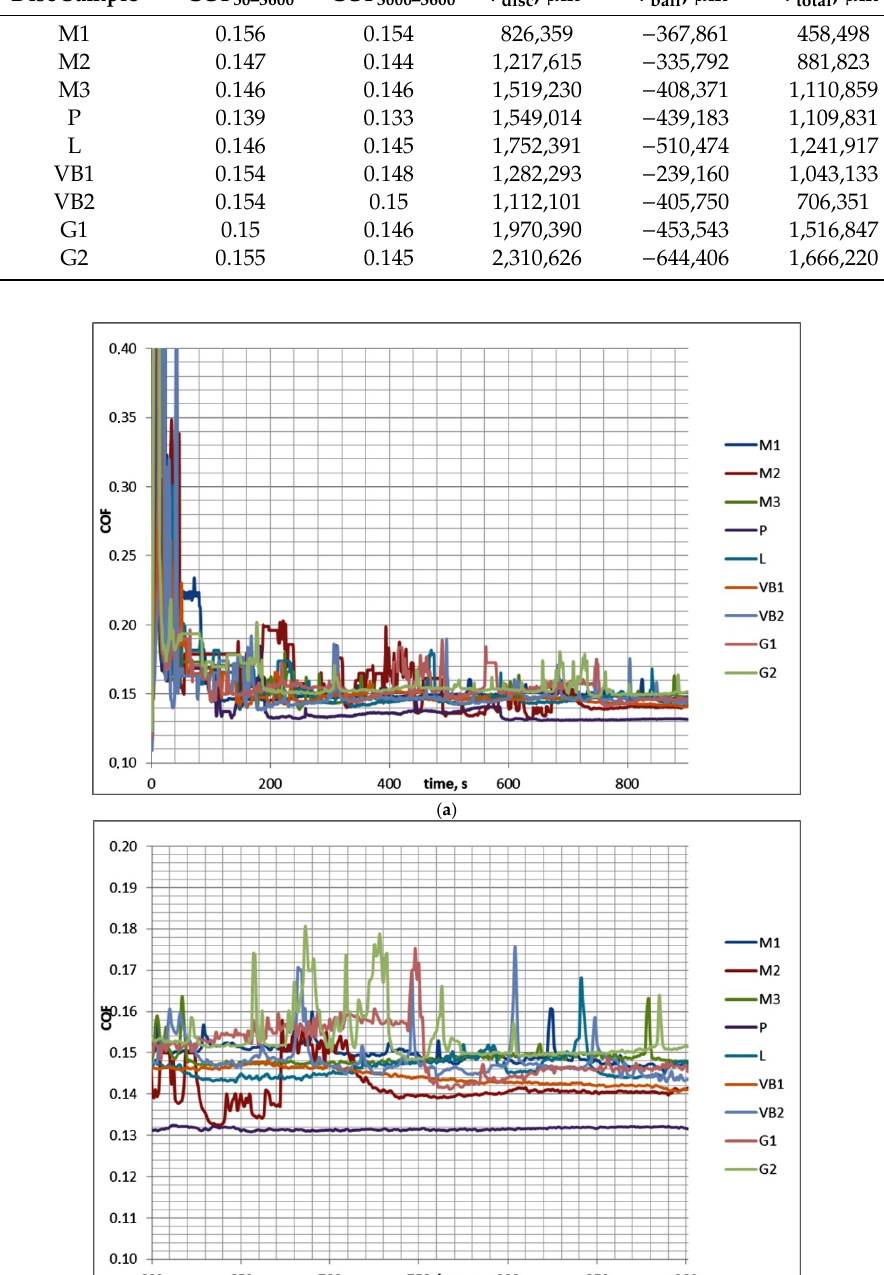
Table 6. Results of test C (f = 80 Hz, P = 100 N, temperature 30 °C, the number of cycles 72,000).